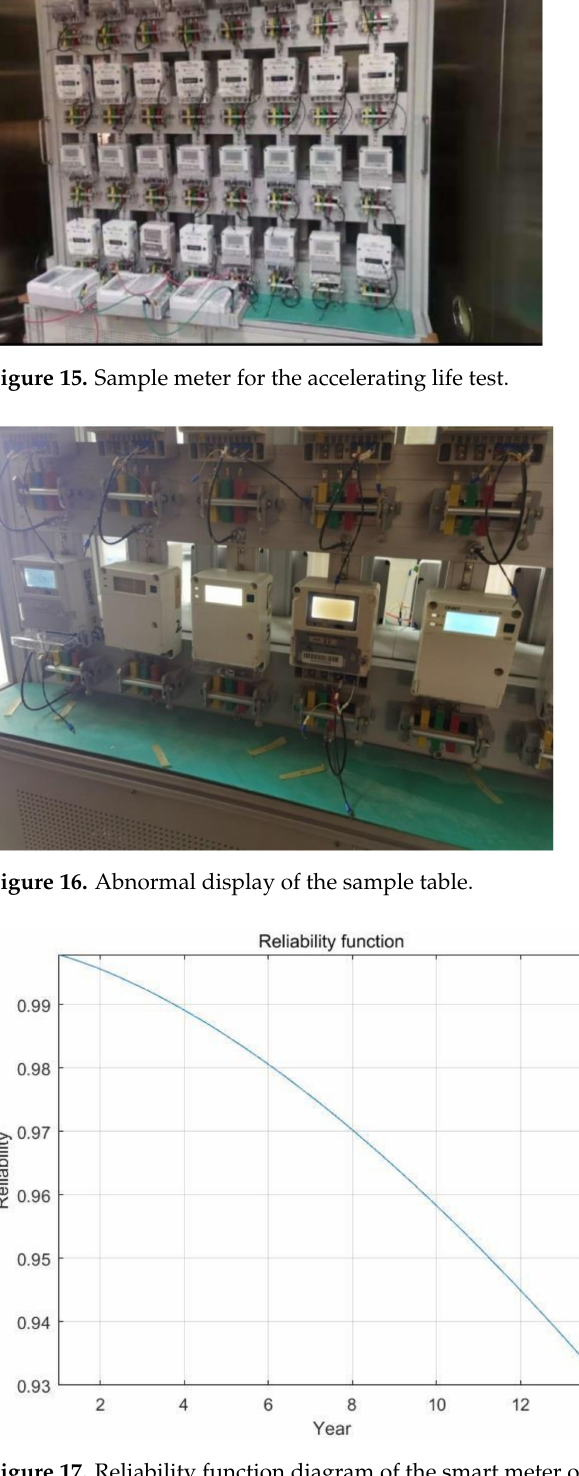
Figure 17. Reliability function diagram of the smart meter obtained by the accelerated life